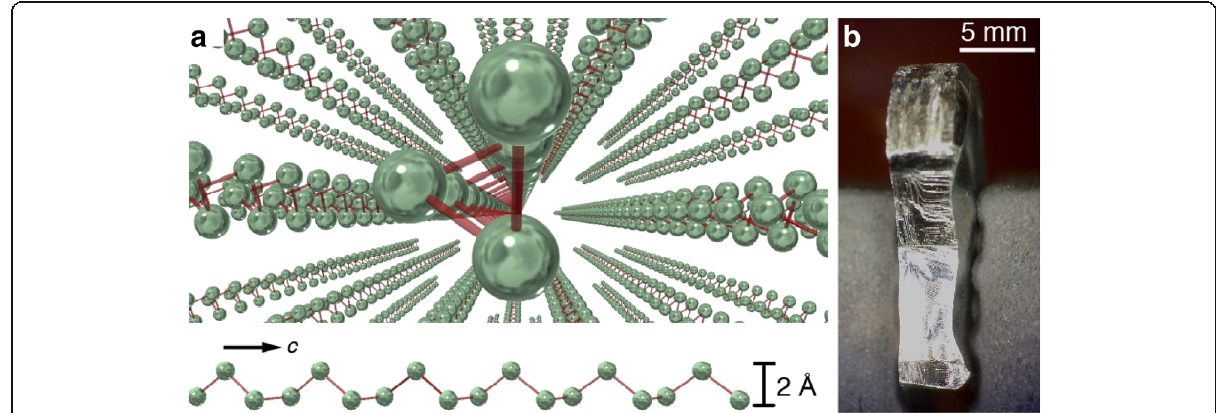
Fig. 1 a Schematic of Te single crystal formed by single atom chains bonded by van der Waals force ( top ) and side view of Te chain structure ( bottom ). Note: 2 Å is the height of the triangular cross-section of a chain while the inter-chain distance is 3.4 Å. b Te single crystal used for